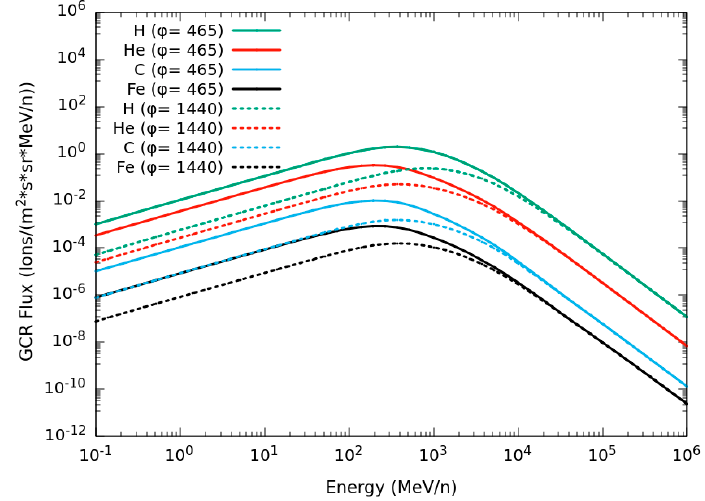
Figure 1. H, He, C and Fe components of the GCR flux at ϕ = 465 (solid lines; solar minimum) and ϕ = 1440 (dashed lines; solar maximum). Afterwards, absorbed doses, equivalent doses and the corresponding relative biological effectiveness (RBE) values were calculated. While the equivalent doses to different tissues/organs were calculated using the Q-values reported in ICRP publication 60 [39], the RBE calculation was based on the BIANCA biophysical code, as described in the next section. Briefly, two radiobiological databases generated with BIANCA were considered: the first one describing human skin fibroblast (HSF) cell death, the second one describing the induction of dicentric chromosomes in blood lymphocytes. Both databases consist of linear and quadratic coefficients allowing dose–response to be predicted as a